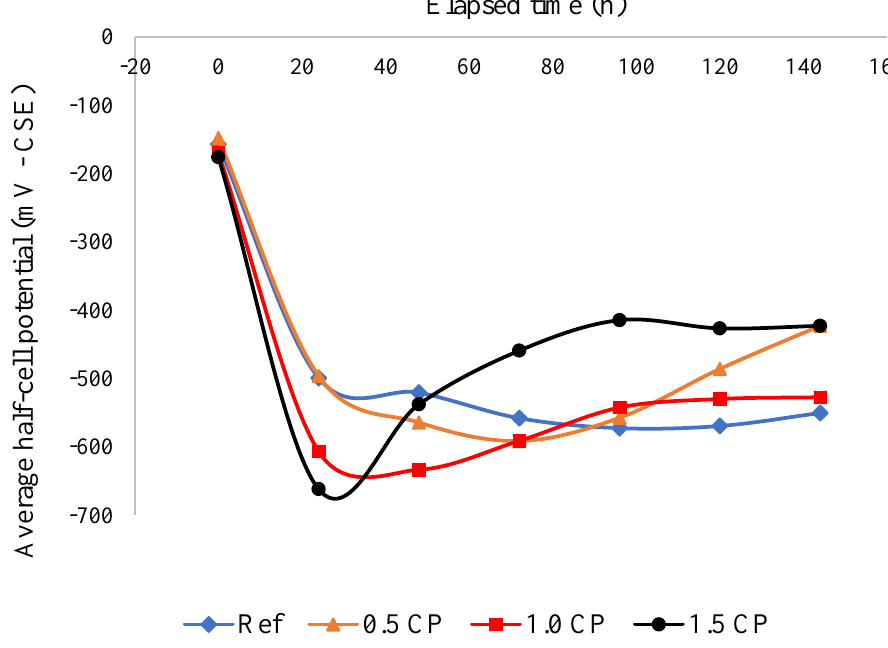
Figure 2. Half-cell potential measurements.